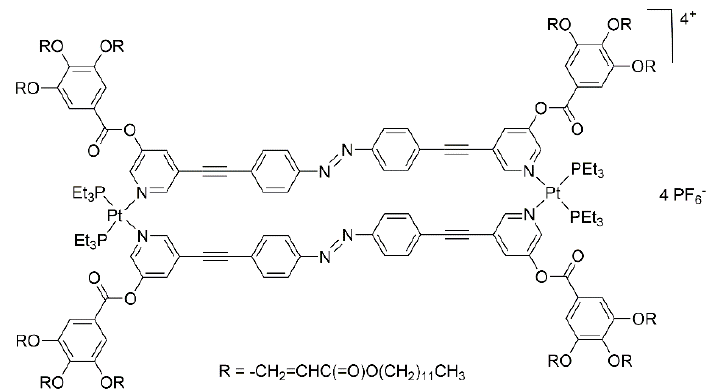
Figure 3. A dinuclear platinum-based metalla-cycle with Col H liquid-crystalline properties in polar solvents [27].